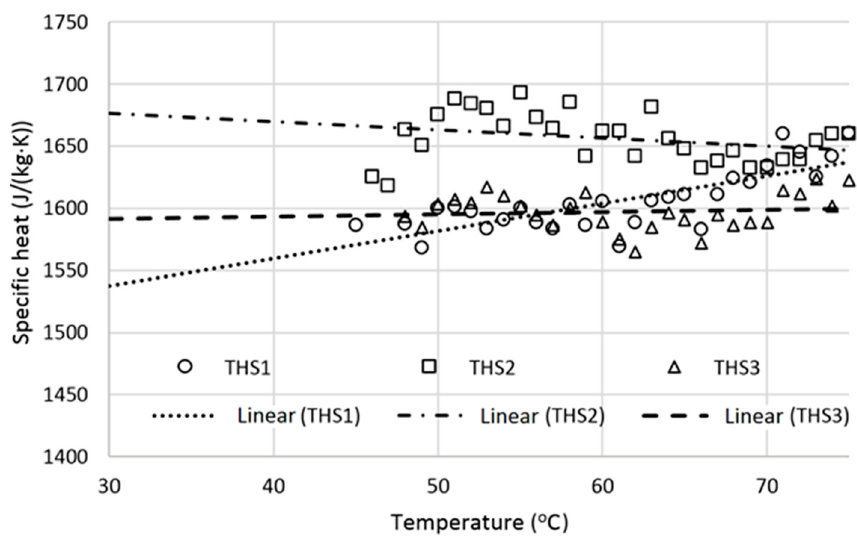
Figure 5. Specific heat vs. temperature for THS samples.